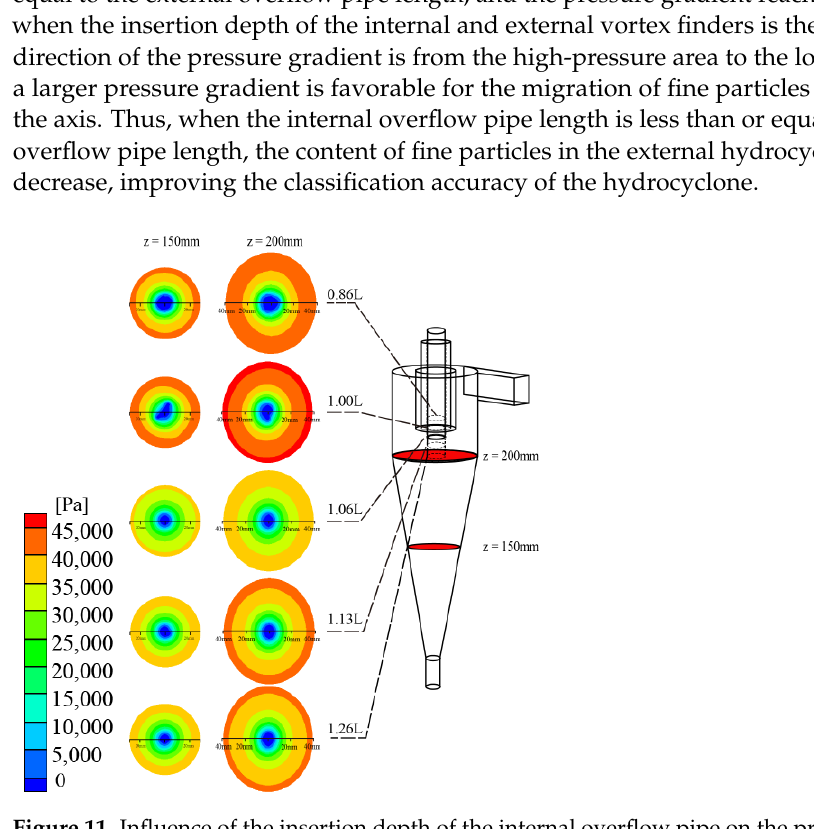
( b ) Figure 12. Influence of insertion depth of the internal vortex finder on tangential velocity. ( a ) z = 150 mm ( b ) z = 200 mm.